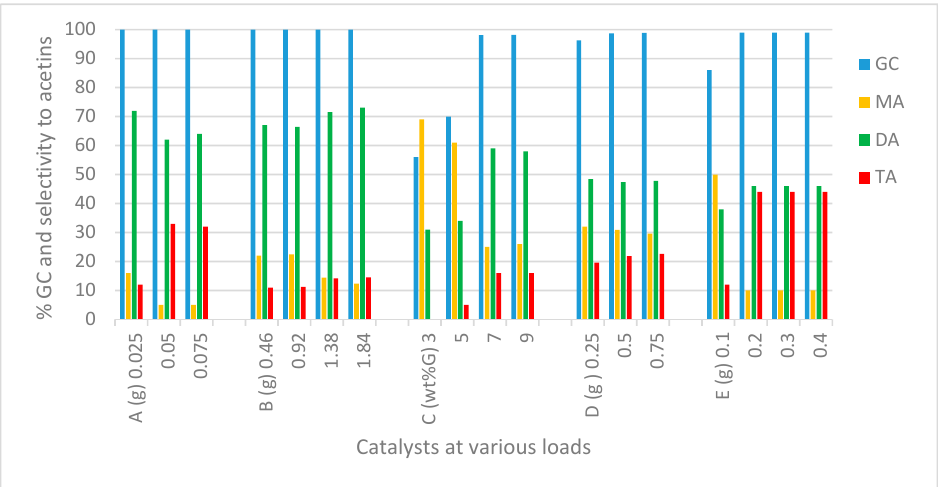
Figure 9. Influence of various catalyst loads on glycerol conversion (GC) and selectivity to monoacetin (MA), diacetin (DA) and triacetin (TA) using different catalysts at various reaction conditions (A = SSBA, glycerol (G):acetic acid (AAc) 1:3, T = 105 °C, t = 3 h [92]; B = glycerol-based carbon, G:AAc 1:4, T = 115 °C, t = 1 h [126]; C = cesium phosphotungstate (CsPWA), G:AAc 1:8, T = 85 °C, t = 2 h [89]; D = 2 M H 2 SO 4 /Al 2 O 3 , G:AAc 1:9, T = 110 °C, t = 5 h [106]; E = glycerol-based carbon, G:AAc 1:3, T = 110 °C, t = 3 h [114].